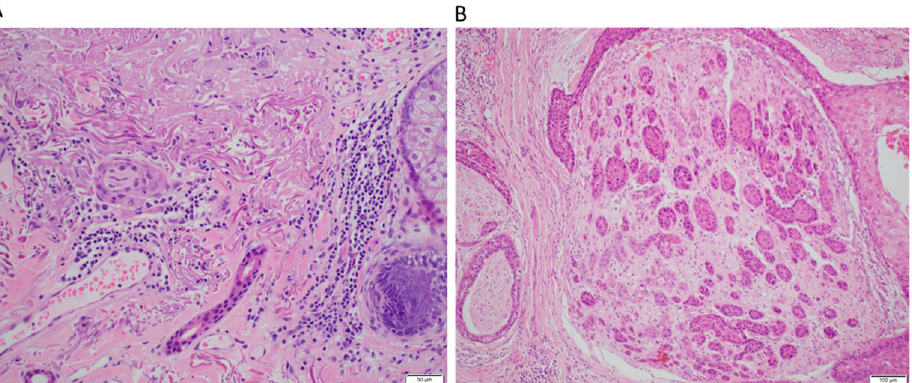
Figure 6. Representative images of H&E stained specimens with perineural invasion. Left image demonstrates a single focus of perineural invasion within the dermis beyond the invasive front of the tumour (×20). Right image demonstrates extensive perineural invasion of a major nerve